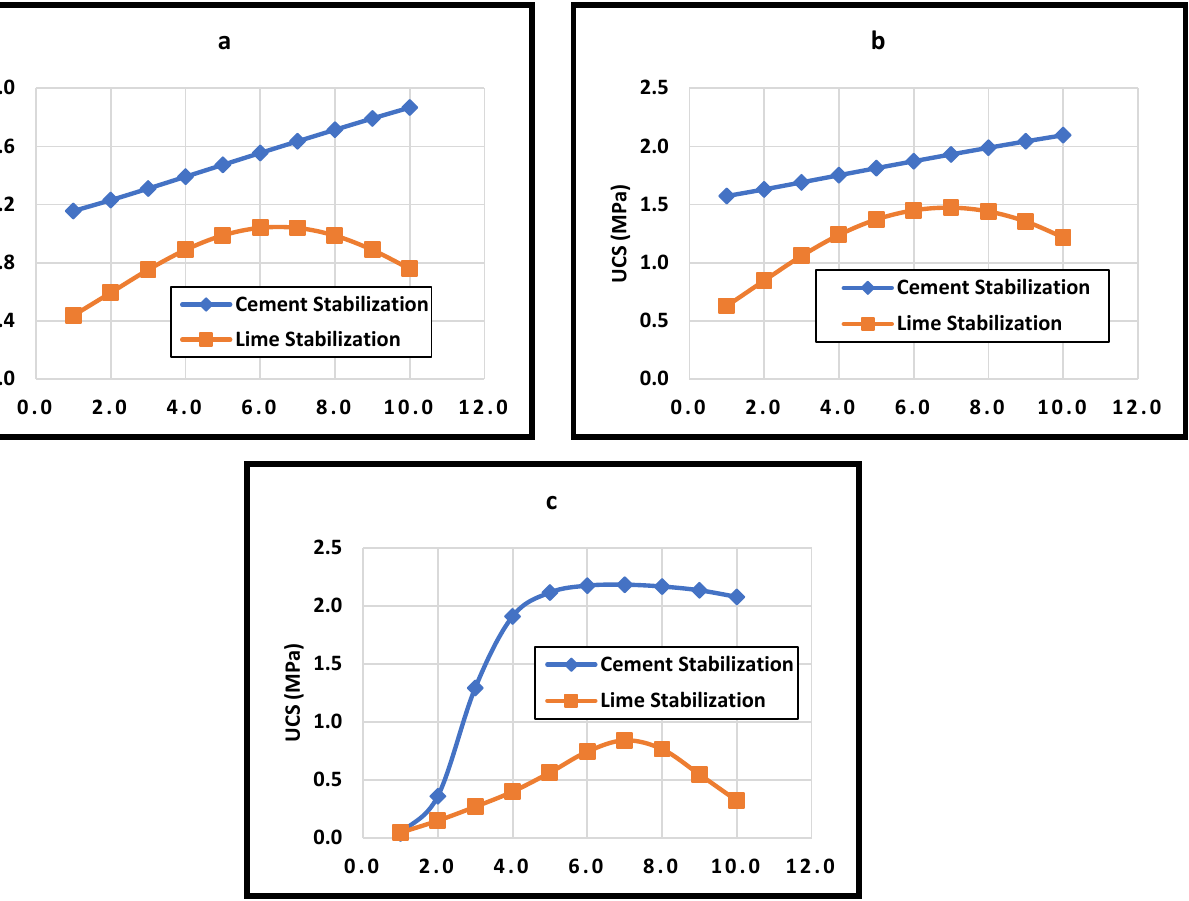
Figure 8. The effect of different parameters on the unconfined compressive strength of stabilized soil. ( a ) All inputs are kept at their average values; ( b ) Soil performance at a density of 1800 kg/m 3 and 18% OMC; ( c ) Soil performance with the inputs vary as the stabilizer content increase.